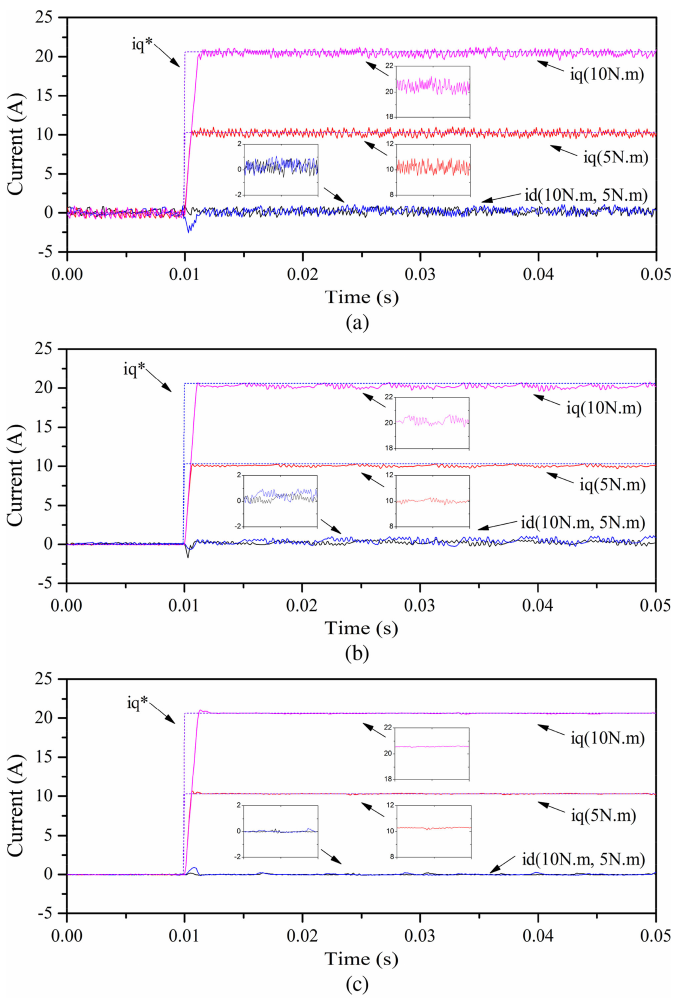
MPC. ( b ) Duty cycle MPC. ( c ) Model −